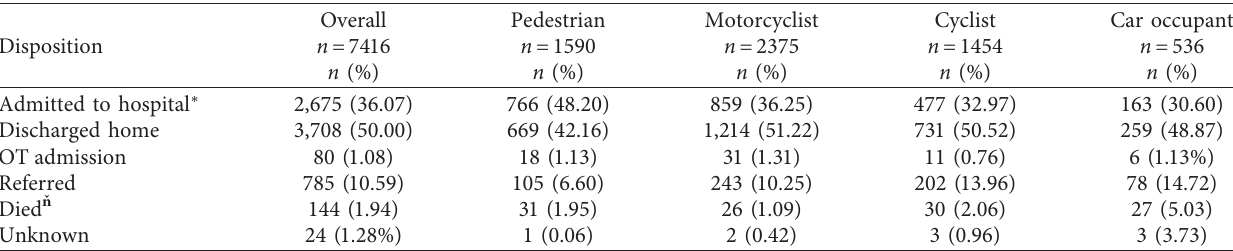
Table 4: Final EU disposition by patient’s